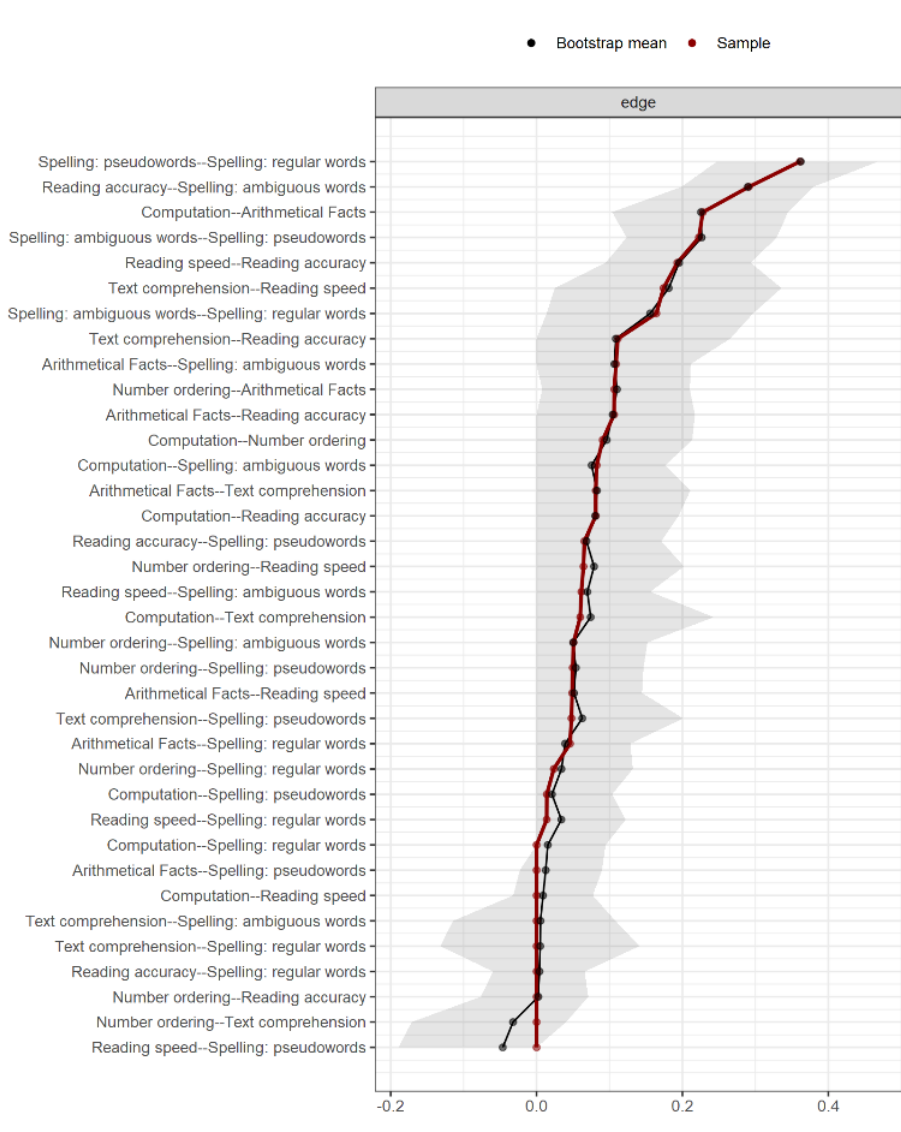
Figure 3. Full list of edges and results from the 1000 bootstraps. Red dots indicate the edge value of the estimated network. Black dots indicate the average edge value over 1000 bootstrap resampling. The grey shadow represents the 95% confidence interval estimated with the bootstrap resampling. Edges are ordered by their estimated strength. Table 2. The lower part (dark background) reports the network weights, which correspond to regularised partial correlations. The upper part (light background) reports simple correlations, measured with Pearson’s r. The diagonal reports the strength centrality index. The first column reports the mean z scores ± the standard deviations.